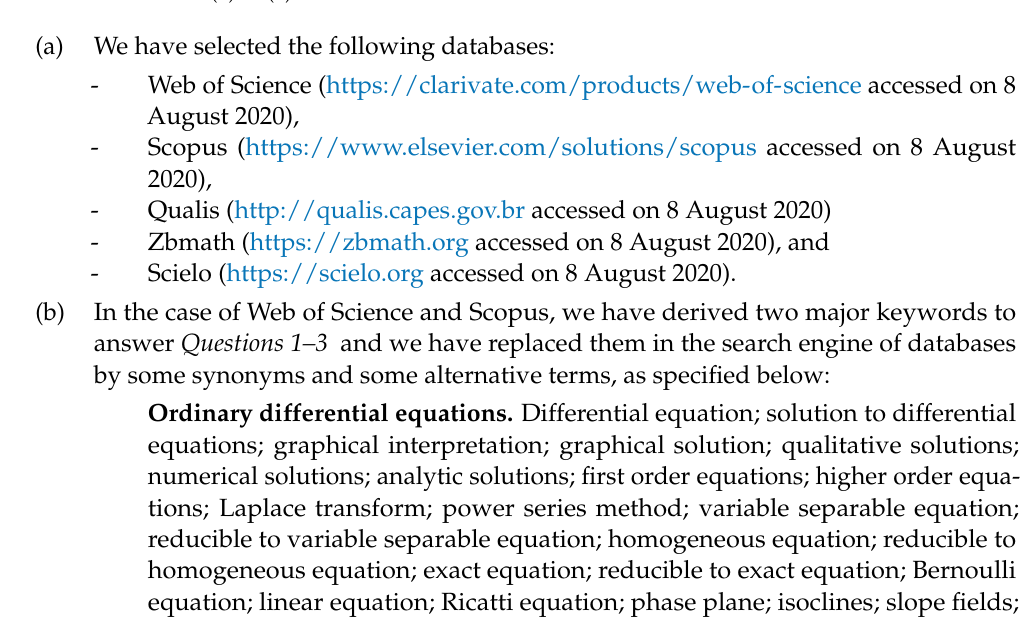
Figure 1. Schematic presentation of the process used for identify the relevant work. For specifications, consult the items (a) to (e) in Section